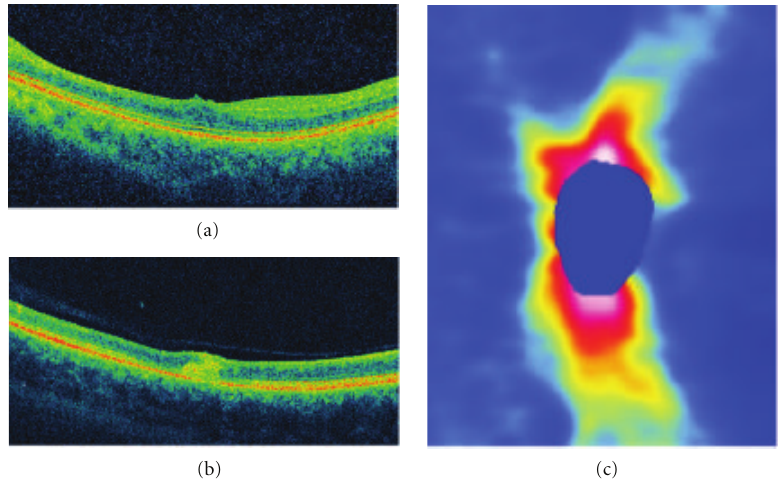
Figure 1: (a) Abnormal foveal architecture in a patient with early-stage DUSN. (b) B-scan in the area the worm was located showing an increased intraretinal reflectivity corresponding to the worm and the surrounded inflammatory reaction. (c) RNFL map with a di ff use thinning.